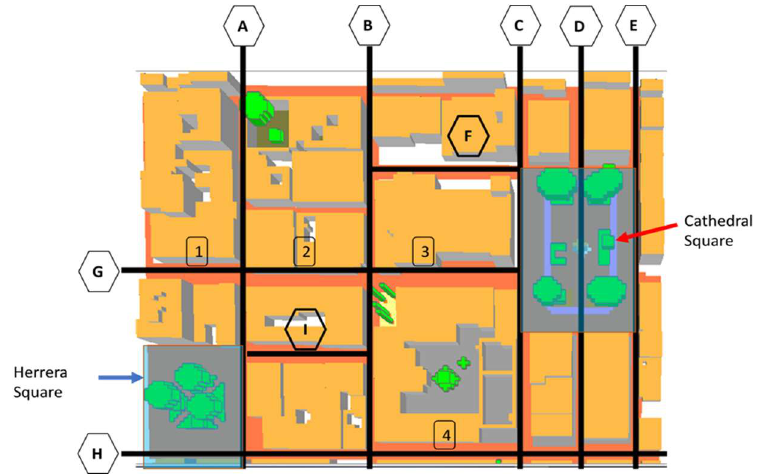
Figure 10. Distribution and arrangement of